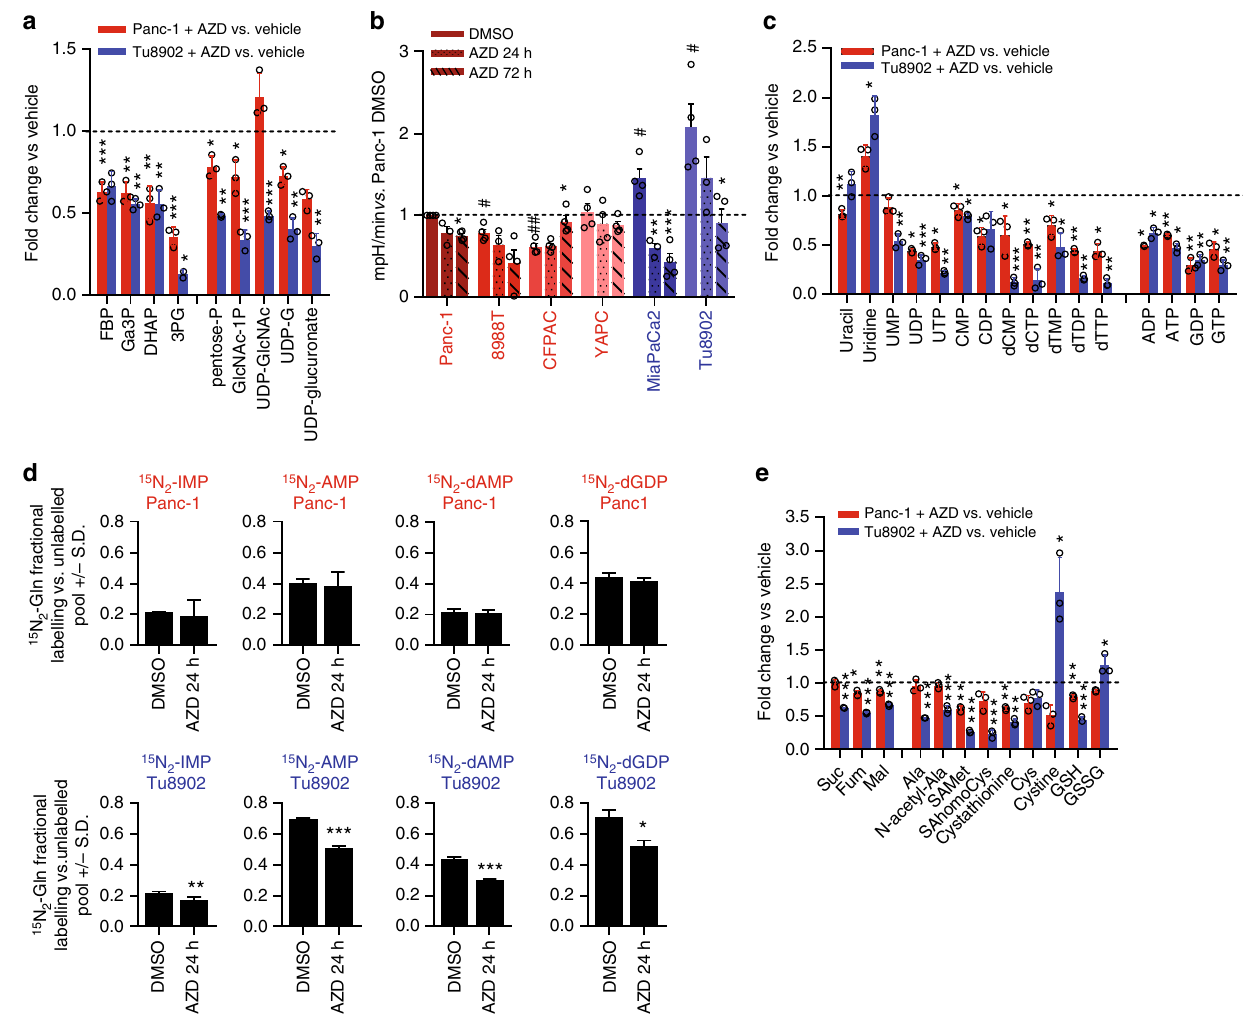
Fig. 3 MEK inhibitor-induced metabolic reprogramming is comparable to shKras. a For all metabolomics experiments in this fi gure, cells were treated with AZD8330 (50 nM) for 72 h in media containing glucose 25 mM and glutamine 4 mM. Values are represented as fold change vs. DMSO-treated cells for glycolysis, PPP and HBP metabolites. Error bars represent s.d. of n = 3 technical replicates from independently prepared samples from individual wells. Signi fi cance determined for each cell line treated with AZD8330 vs. vehicle . b Quanti fi cation of Extracellular Acidi fi cation Rate (ECAR) normalized to cell number determined by crystal violet staining. All values relative to Panc-1 DMSO, error bars ± s.e.m. of independent experiments (* shows comparison to each cell line ’ s control (DMSO), # shows comparison to Panc1-DMSO). c Fold change of metabolites in the pyrimidine and purine pathways after AZD8330 treatment. UMP, uridine monophosphate; CDP, cytidine diphosphate, CTP, cytidine triphosphate; dCTP, deoxy CTP; dTTP, deoxy thymidine triphosphate; IMP, inosine monophosphate; AMP, adenosine monophosphate; dATP, deoxy adenosine triphosphate; GDP, guanosine diphosphate. Signi fi cance determined for each cell line treated with AZD8330 vs. vehicle. d Tracing experiments in Panc-1 and Tu8902 cells treated with AZD8330 (50 nM) in medium containing stable isotope-labeled glutamine (Amide-15N) for 24 h to label incorporation into the purine ring. Bars show fractional labeling vs. unlabeled pool, error bars indicate ± s.d. of n = 3 technical replicates from independently prepared samples from individual wells. e Fold change of metabolites in the tricarboxylic acid (TCA) cycle, transaminase and redox pathways after AZD8330 treatment, error bars indicate ± s.d. of n = 3 technical replicates from independently prepared samples from individual wells. Signi fi cance determined for each cell line treated with AZD8330 vs. vehicle. Ala, alanine; SAHomoCys, S-adenosyl-L-homocysteine; GSH, reduced glutathione; GSSG, oxidized glutathione. For all panels, signi fi cance determined with t-